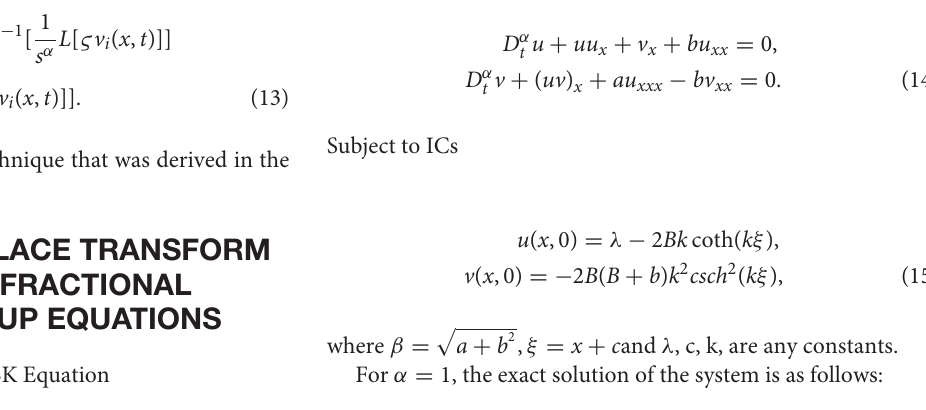
TABLE 3 | Second-order DJ solution for u ( x , t ) in comparison with ADM, VIM, and OHAM solutions at α